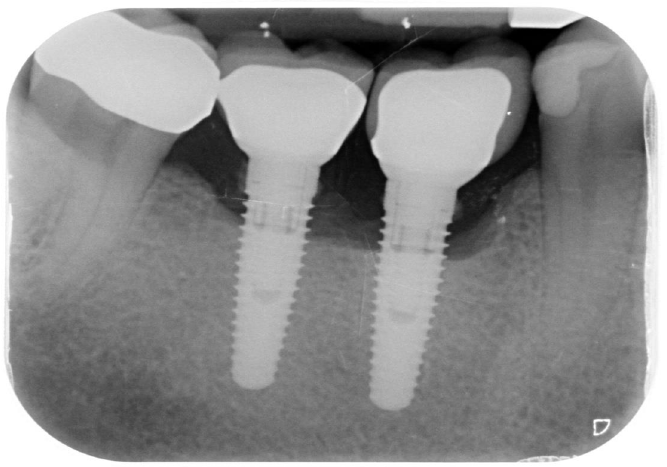
Figure 1. Periapical radiograph of implants affected by peri-implantitis in the lower right quadrant. All patients had previously been treated non-surgically, and only those patients with Probing Depth > 6 mm and lack of implant mobility had been considered for surgical treatment. In order to be treated with regenerative surgical procedures, patients had to be non-smokers or smoke fewer than 10 cigarettes per day [20]. All the patients received a professional hygiene session 2–3 days before the surgical treatment; this was performed to reduce the intraoral bacterial load. The proposed treatment consisted of a combination of surgical and antimicrobial therapy. All patients received antibiotic prophylaxis with 2 g amoxicillin 1 h prior to the surgery. Before the procedure, all patients had a 1 min mouth rinse with 0.2% chlorhexidine. Articaine 4% with 1:100,000 adrenaline was used for the local anesthesia by infiltration; mandibular block was also used in the mandible (Figure 2).